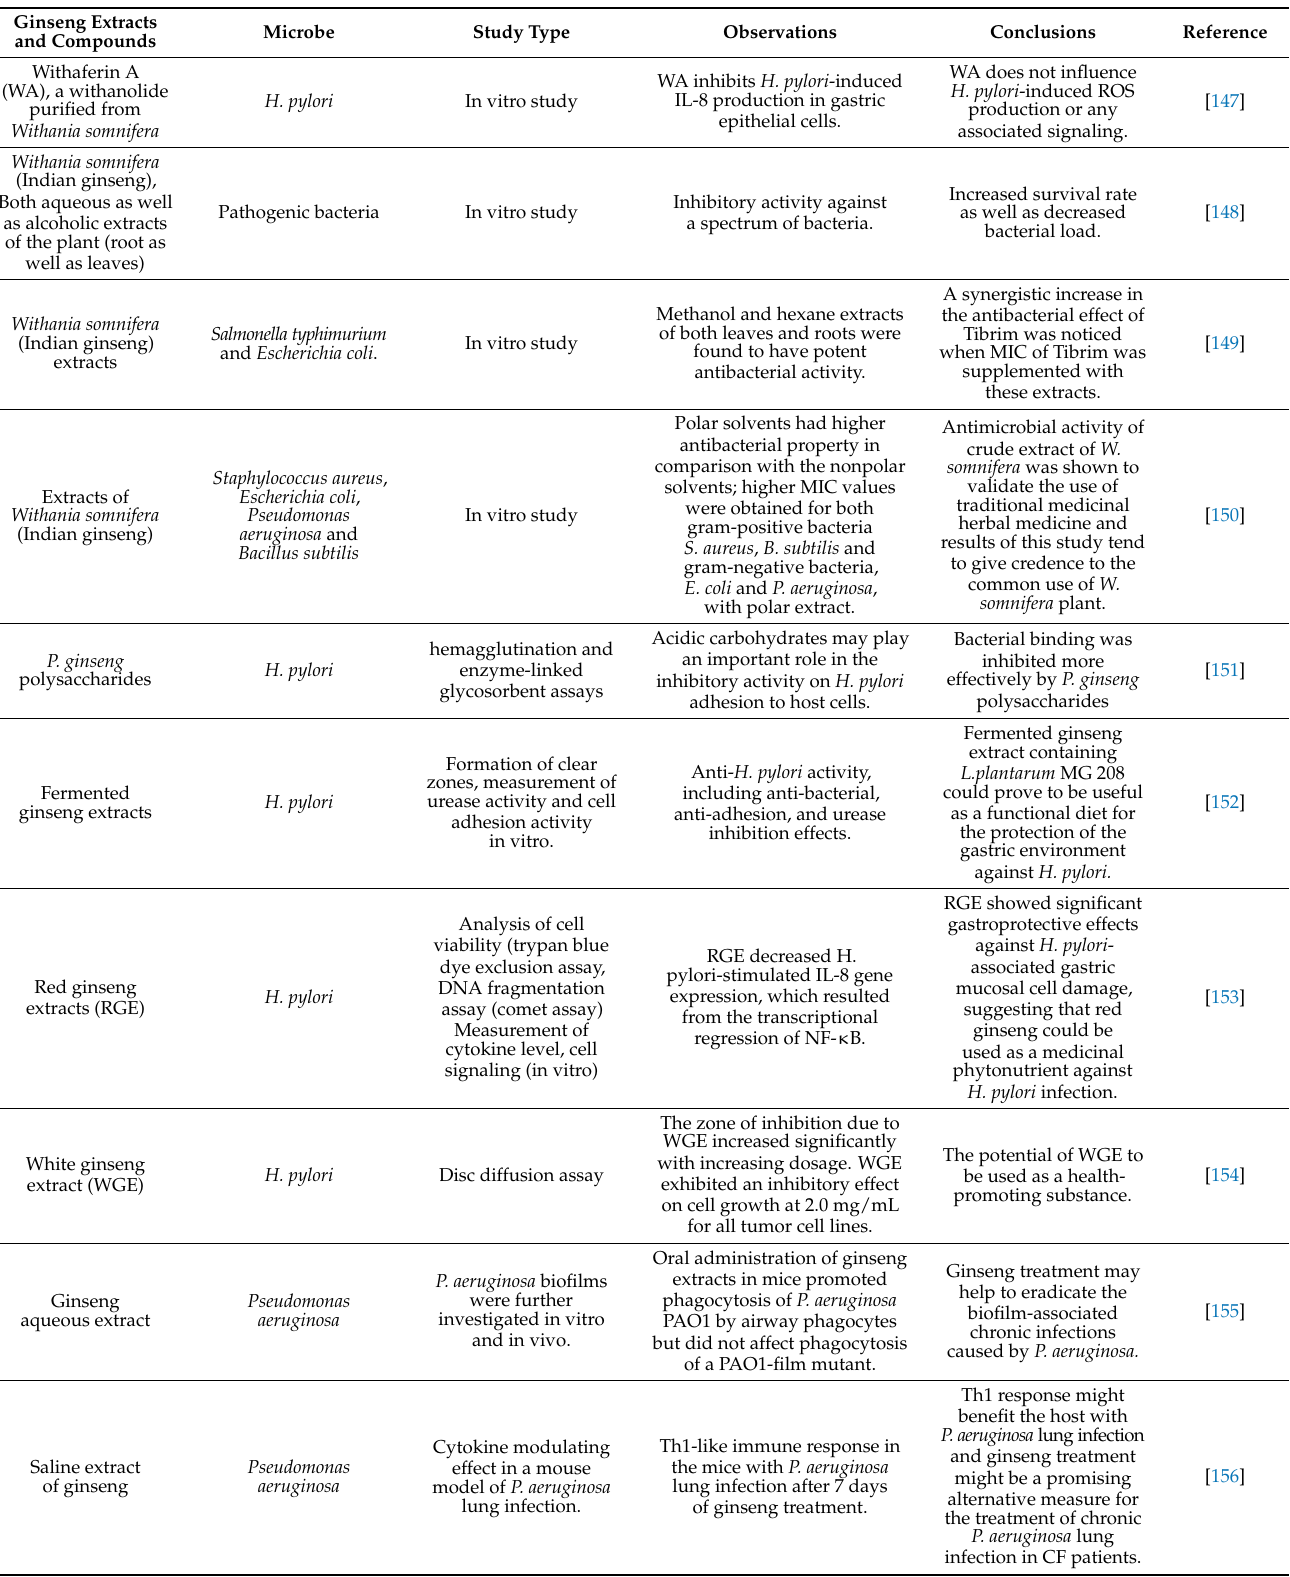
Table 2. Effects of ginseng on bacterial infections of the respiratory